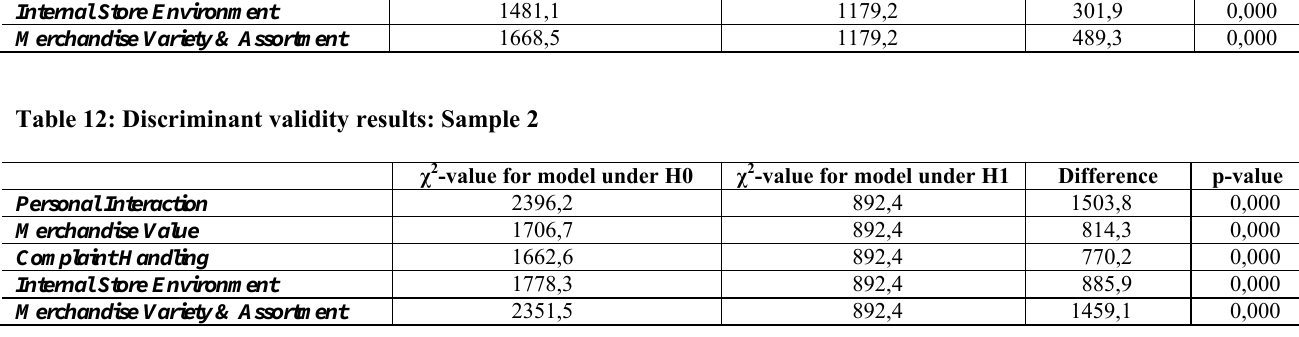
χ 2 -value for model under H0